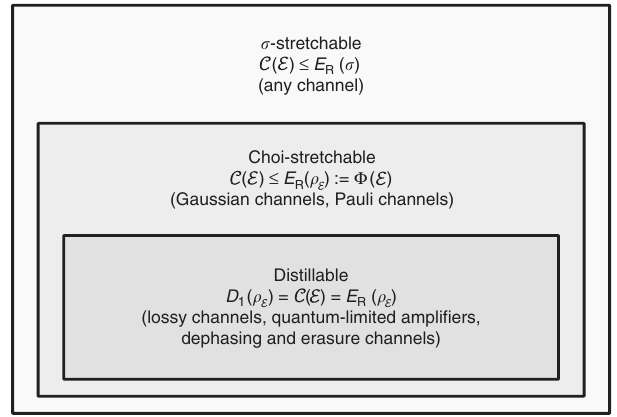
Figure 5 | Classification of channels in DVs and CVs. We depict the classes of channels that are considered in this work, together with the bounds for their two-way